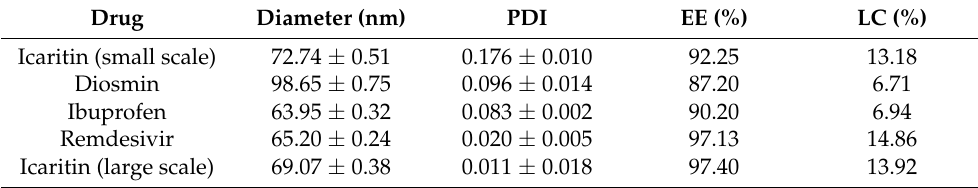
Table 1. Characteristics of drug-loaded polymeric micelles prepared via ABS method ( n = 3). Drug Diameter